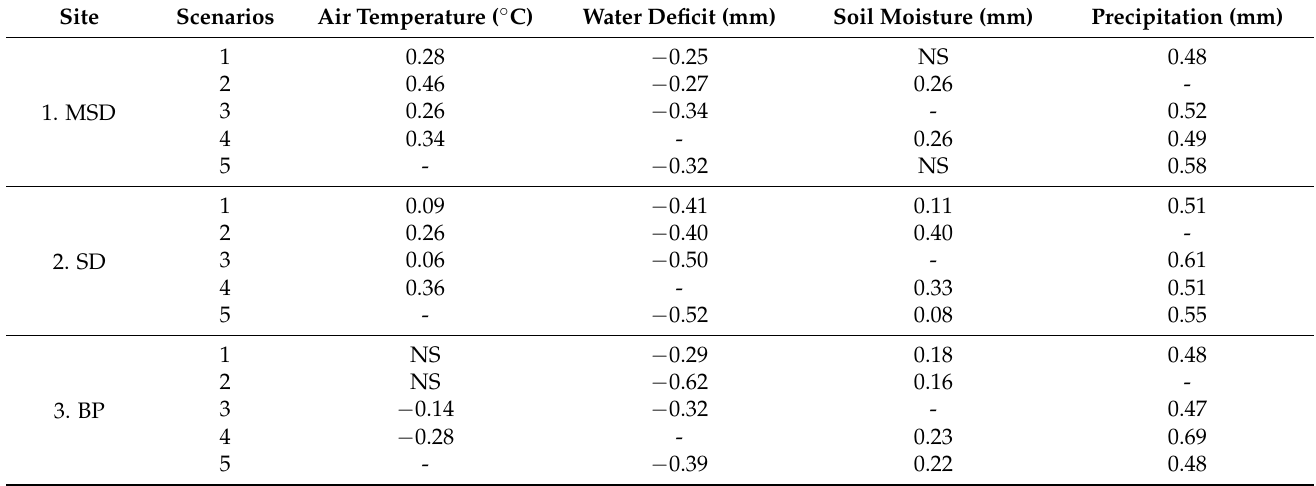
Table 1. Partial correlation coefficients between the EVI and environment drivers across MSD, SD, and BP sites. Scenario 1 considers all environmental drivers to calculate partial correlations. For the other scenarios, the effect of one of the variables is removed: scenarios 2 (without precipitation), 3 (without soil moisture), 4 (without water deficit), and 5 (without temperature). “-” indicates that the environment driver was not used to calculate the partial correlation. Only for statistical significance ( p < 0.05). Missing estimates (NS) are not